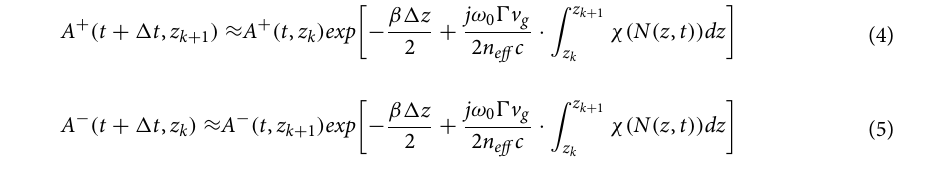
light. A schematic of the TWM numerical scheme is depicted in Fig. 1. Combining Eqs. (1) and (3), the wave solutions in each segment z k